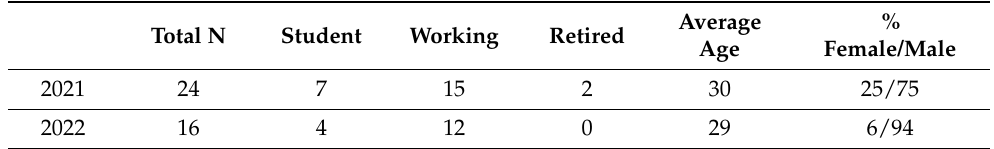
Table 1. Participants in the 2021 Drawing and Storytelling Workshop, the American Space, Dushanbe, August 2021–2022.